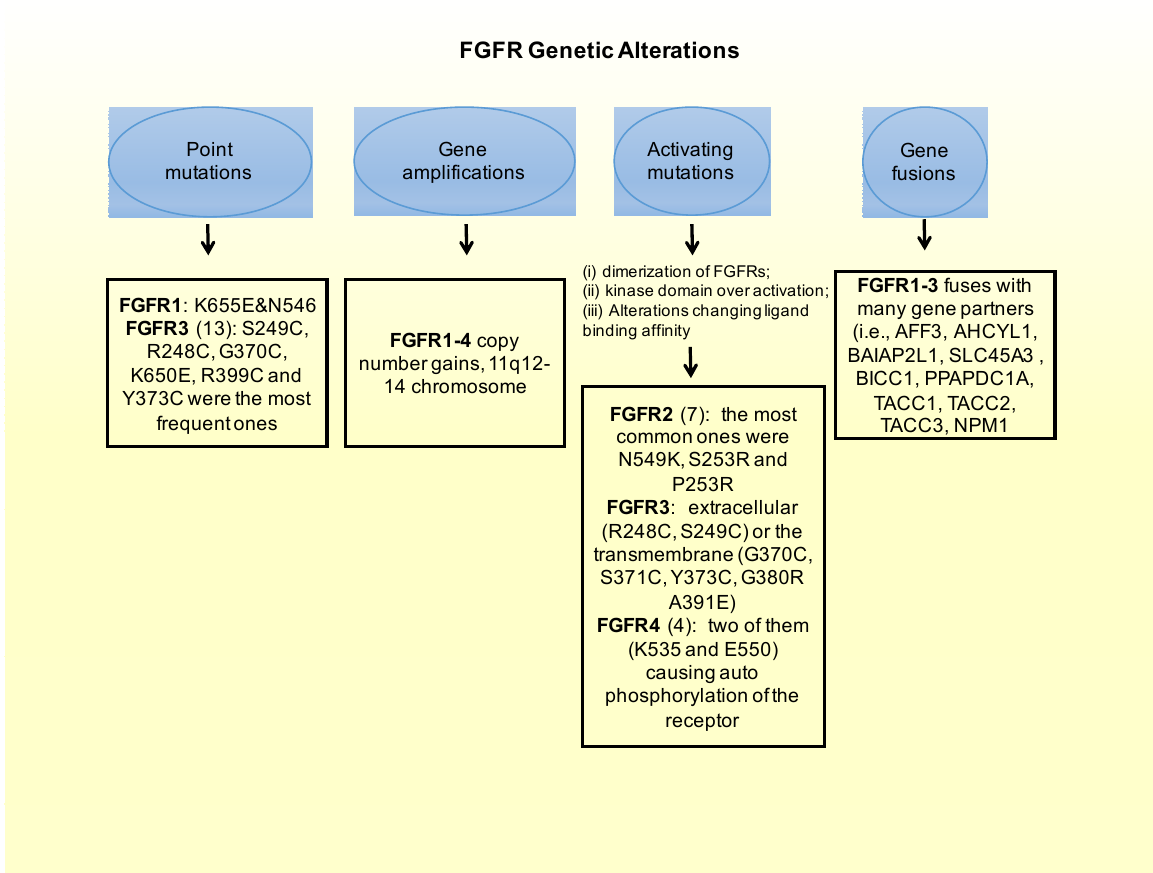
Figure 2. FGFR genetic alterations leading to breast cancer.